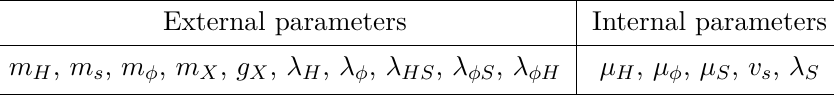
Table 2 . External and internal parameters of the model